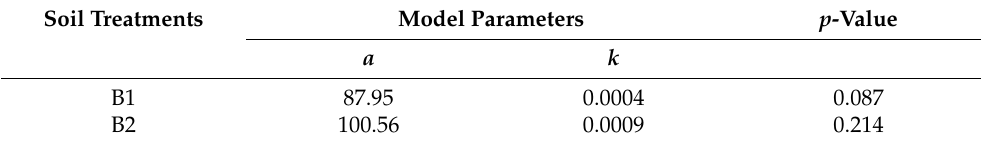
Table 3. Exponential decay model parameters and model statistical significance.